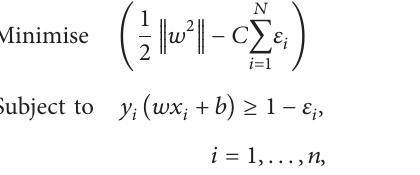
Figure 2: An example of optimal separating